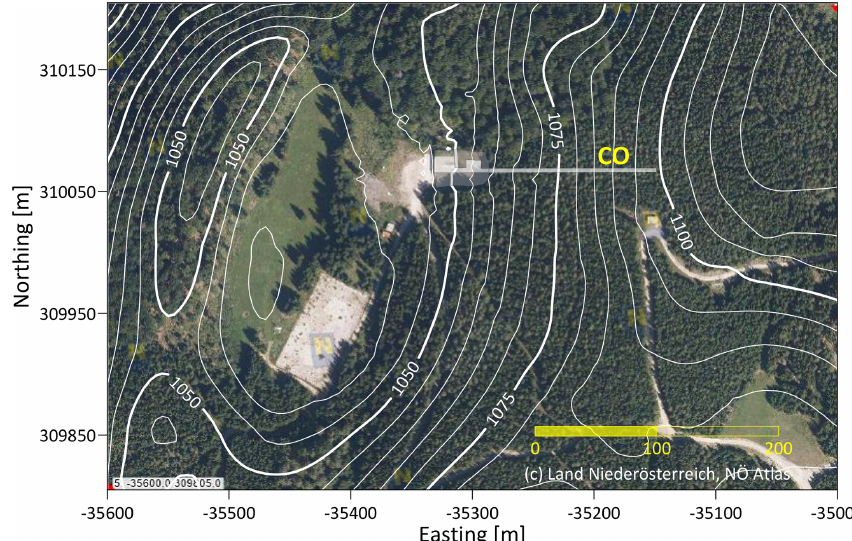
Figure 2. Map of the close surroundings of Conrad Observatory (© Land Niederösterreich, NÖ Atlas). Contour lines represent the topography elevation (metres) of a high-resolution digital terrain model (DTM) used for modelling. The outline of the observatory, including the 150m long tunnel, is displayed as well. Details are presented in Fig.